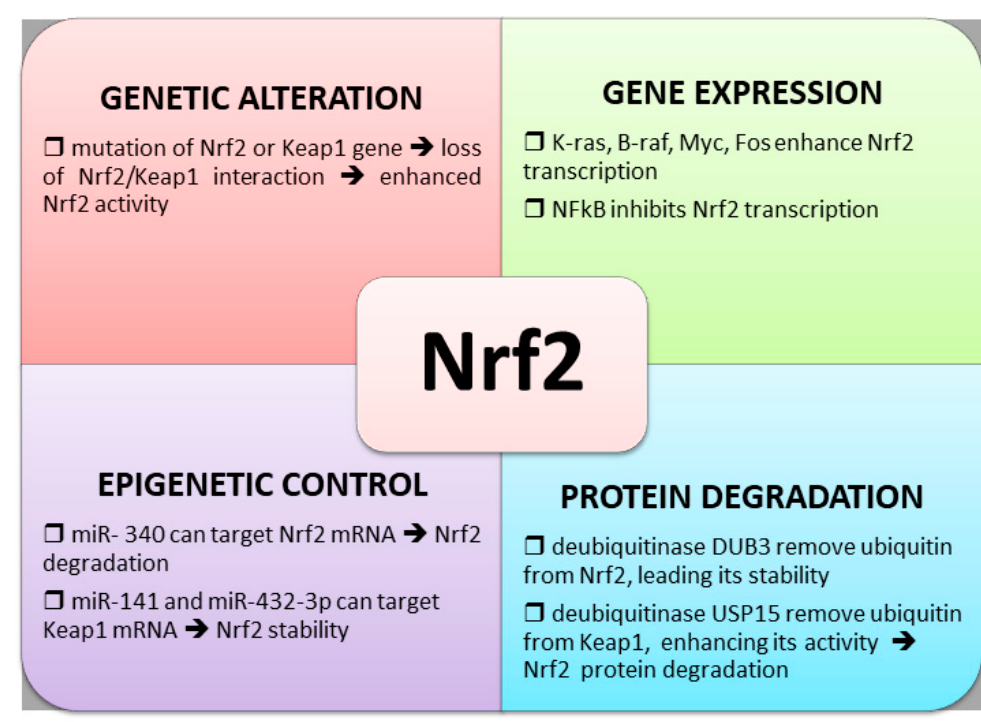
Figure 3. Mechanisms of control of Nrf2 activity.